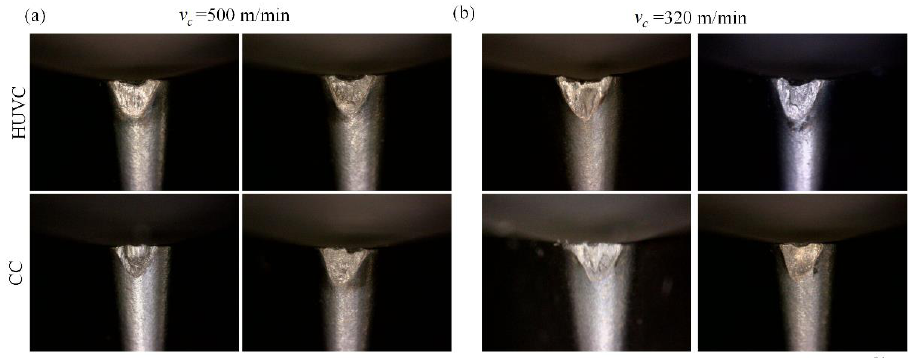
Figure 13. Cutting edge breaking of the flank wear of cemented carbide tools when machining ( a ) Ti alloys. Cooling pressure, duty cycle, feed per revolution, and cutting depth are 20 MPa, 0.5, 0.005 mm/r, 0.05 mm, respectively, and ( b ) Ni alloys. Cooling pressure, duty cycle, feed per revolution, and cutting depth are 10 MPa, 0.5, 0.005 mm/r, and 0.2 mm, respectively. v c , cutting speed.